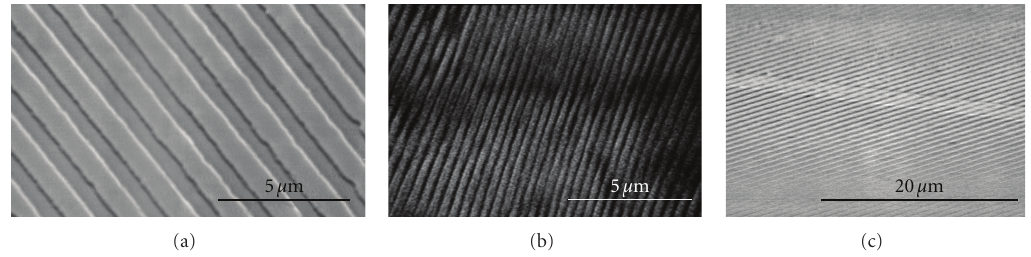
Figure 4: (a) SPP-LT with period 1.5 μ m; (b) SPP-LN with period400nm; (c) PE channel waveguide fabricated on